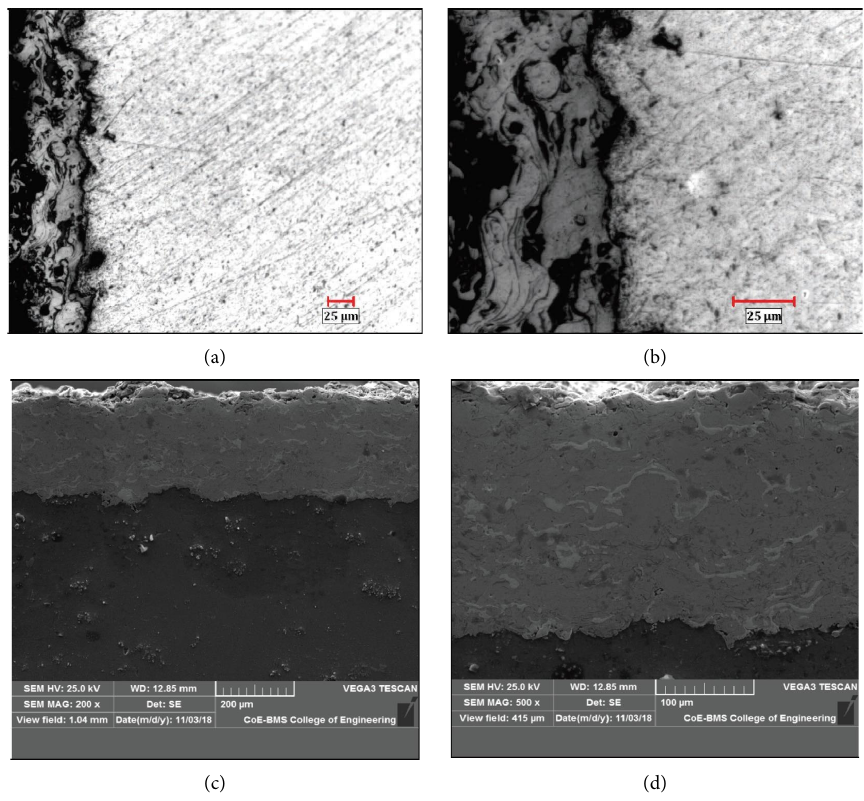
Figure 4: Optical and SEM images of WC-10% Ni coatings.